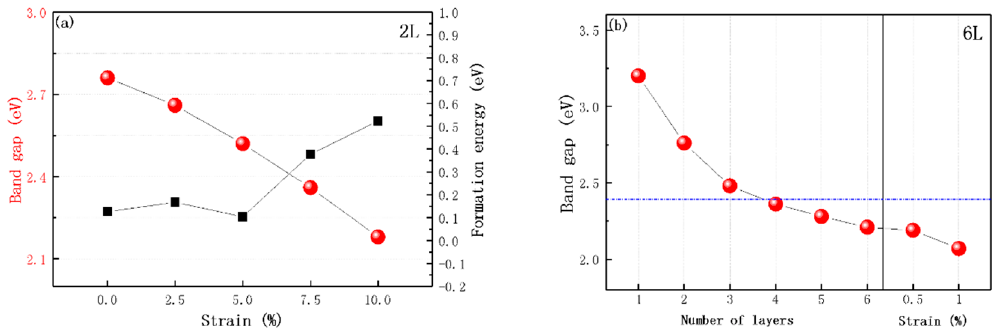
Figure 3. ( a ) Bandgap and formation energy of 2L ZnO under different strains are represented by red balls and black squares, respectively. ( b ) The bandgap of nL ZnO and 6L ZnO under 0.5% and 1% strains; the blue dashed line indicates the bandgap of bulk ZnO calculated using the HSE06 functional.